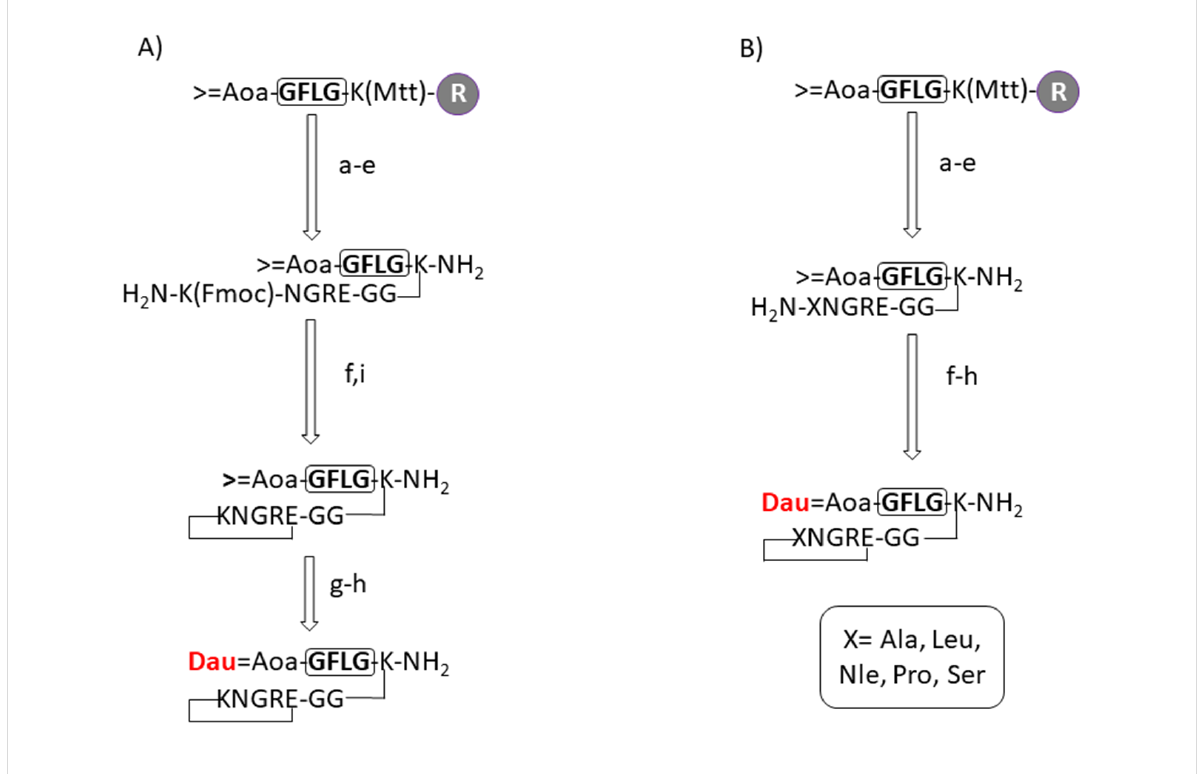
Figure 1: Schematic synthesis of cyclic KNGRE (A) and XNGRE (B) drug conjugates. a) Mtt-cleavage: 2% TFA/DCM; b) Fmoc-Aaa(X)-OH coupling; c) Fmoc-cleavage 2% piperidine/2% DBU/DMF, 0.1 M HOBt; d) cleavage from resin 2.5% TIS/2.5% H 2 O/95% TFA (rt, 3 h); e) salt exchange Pyr·HCl 10 equiv/MeOH (1 h); f) cyclization: BOP 3 equiv/HOBt 3 equiv/DIPEA 6 equiv/DMF ( c = 0.5 mg/mL, rt, 24 h); g) deprotection of aminooxyacetic acid 0.2 M NH 4 OAc solution (pH 5.0)/1 M methoxylamine (rt, 1 h); h) daunomycin conjugation (rt, 24 h) in 0.2 M NH 4 OAc solution (pH 5.0); i) Fmoc- cleavage 4% hydrazine/DMF (rt, 2 h).